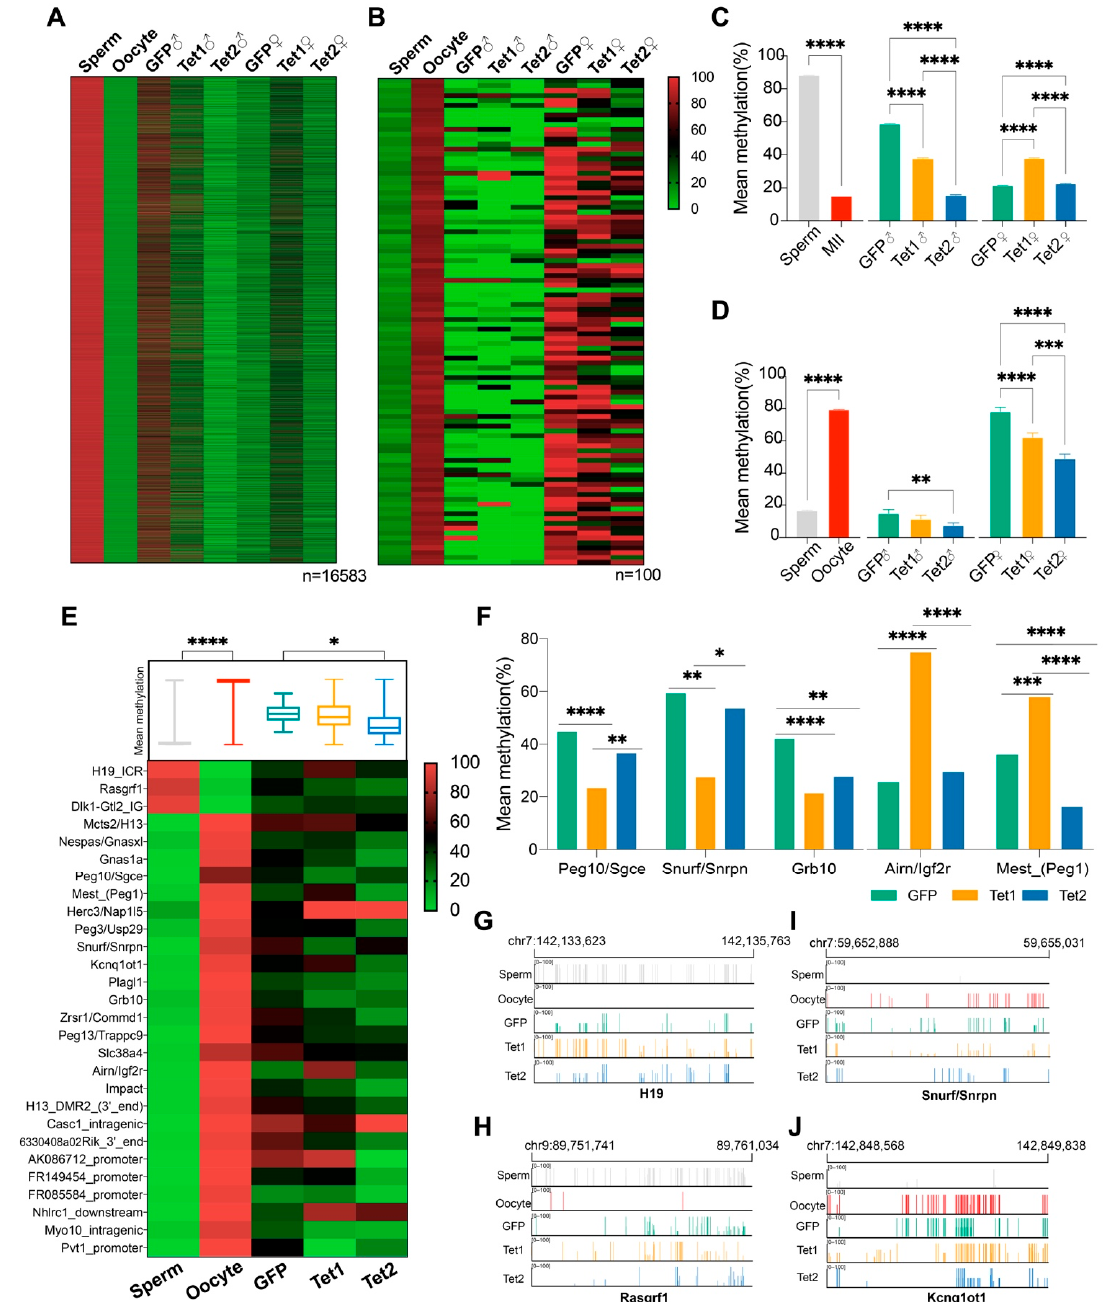
Figure 4. Effects of Tet1 and Tet2 on germline-specific DMRs. Germline-specific DMRs were defined as DMRs with ≥ 75% methylation levels in one parent and ≤ 25% in the other, and were examined for their presentation on the parental genome of zygotes. ( A , B ) Heatmaps for the methylation distribution of sperm-specific DMRs (n = 16,583) ( A ) and oocyte-specific DMRs (n = 100) ( B ). ( C , D ) Bar graphs for the mean methylation ( ± SEM) of the sperm-specific DMRs ( C ) and oocyte-specific DMRs ( D ) were examined in all samples. ( E ) Heatmap for the methylation levels of 25 maternal and 3 paternal known gICRs. The mean methylation of these gICRs from various groups is shown in the box graph above the heatmap. ( F ) Bar graphs for the mean methylation levels of 5 representative gICRs. ( G – J ) Graphical representation of methylation in paternally imprinted genes (H19 and Rasgrf1) and maternal imprinted genes (Snurf/Snrpn and Kcnq1ot1) at a locus in the gametes and zygotes. Different colors of short lines highlight the tracked methylated CpGs. “*”, p < 0.05; “**”, p < 0.01; “***”, p < 0.001; “****”, p <